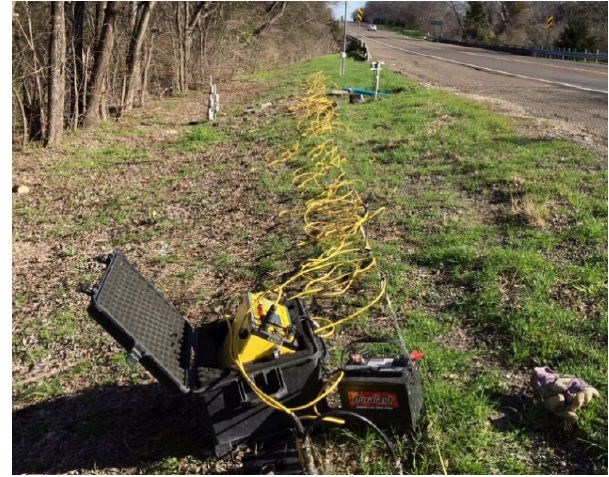
Figure 3. Resistivity set up at slope of SH 342.